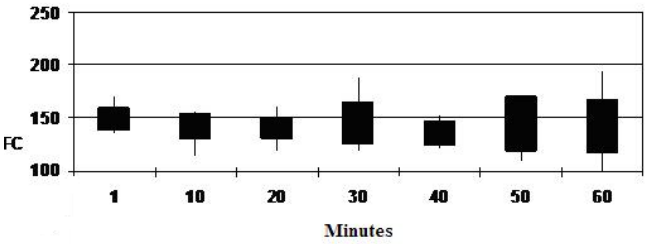
FIGURE 1 - Cardiac Frequency during transoperatory